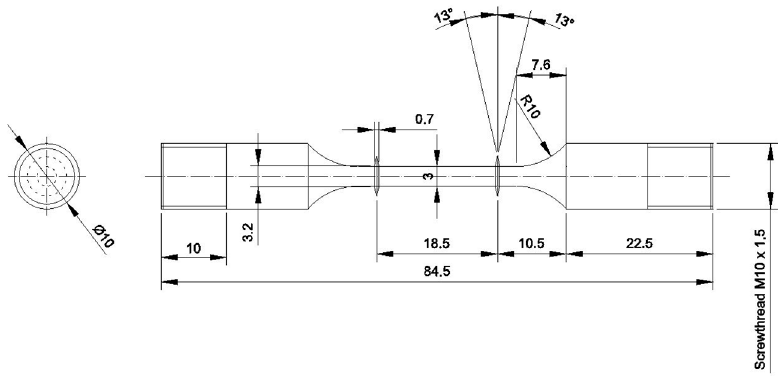
Figure 3. Dimensions (mm) and shape of tensile and creep specimens